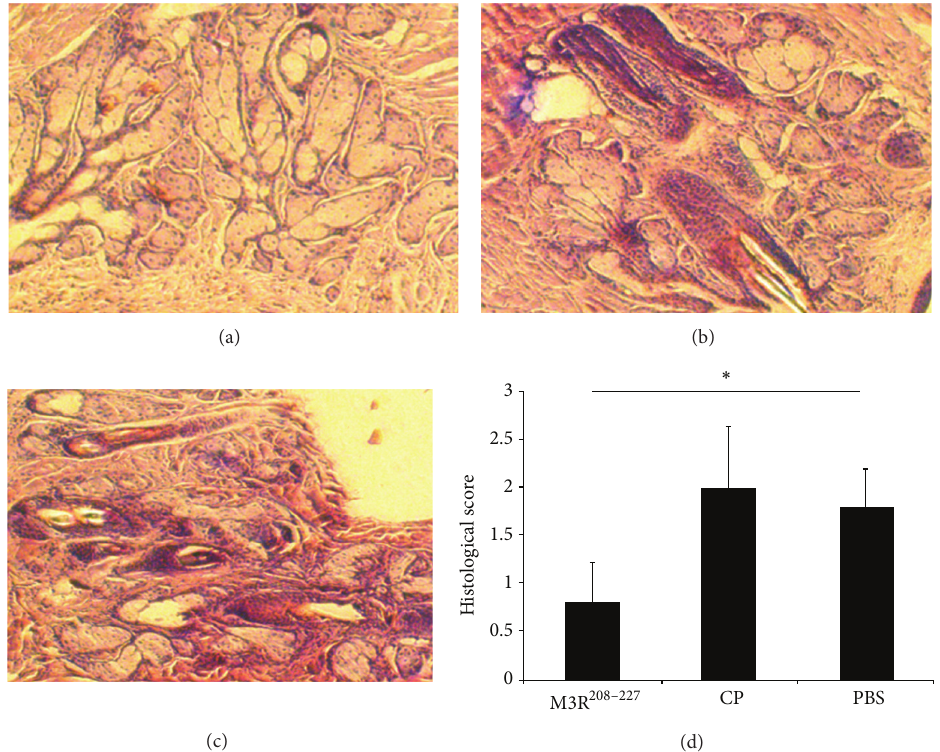
Figure 5: Lymphocytic infiltration was improved in the salivary glands following immunization with the M3R 208−227 peptide. Whole salivary glands of NOD/LtJ mice were surgically removed from each mouse and placed in 10% phosphate-buffered formalin for 20min. After the samples were fixed, embedded, and stained with hematoxylin and eosin (H&E), sections were observed under a microscope. The histological analysis suggested that immunization with M3R 208−227 could reduce the lymphocytic infiltration in the salivary glands of NOD/LtJ mice. (a) Tissue from a NOD/LtJ mouse immunized with the M3R 208−227 peptide. (b) Tissue from a NOD/LtJ mouse immunized with CP. (c) Tissue from a NOD/LtJ mouse immunized with PBS. (d) Mean grade (histological score) of inflammatory lesions in salivary glands of NOD/LtJ mouse immunized with the M3R 208−227 peptide as compared to the controls ( ∗ 𝑃 < 0.05